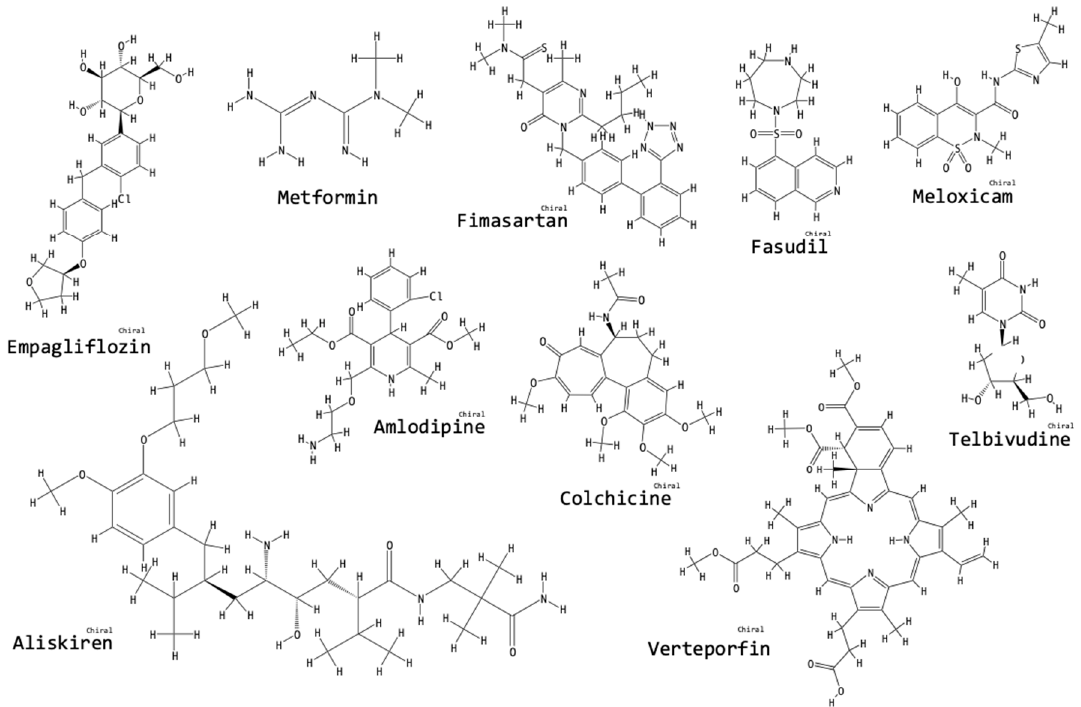
Figure 4. Chemical structures of pharmaceutical compounds tested for fibrosis-ameliorating activity in the context of the UUO model. The structures were obtained from the PubChem database [60]: the “PubChem CID” for each compound has been listed in the text next to the compound’s name.